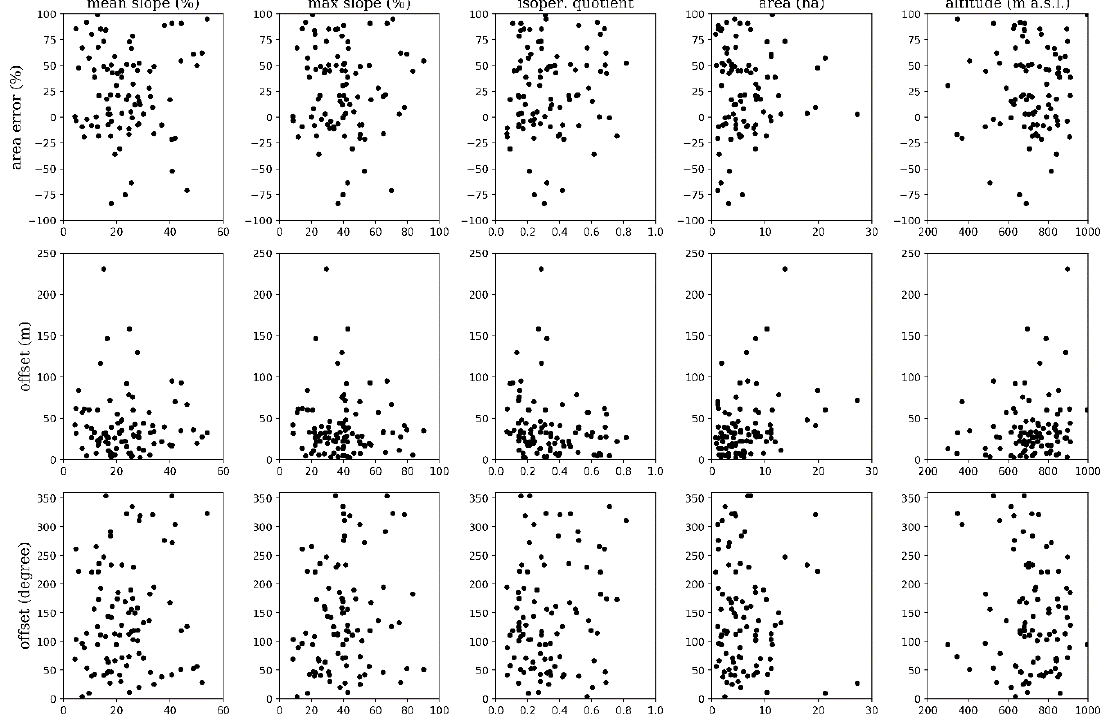
Figure 10. Scatter plot of the explanatory variables (mean slope, maximum slope, isoperimetric quotient, area and altitude), and response variables (percentage area error, offset distance, azimuth of the offset).